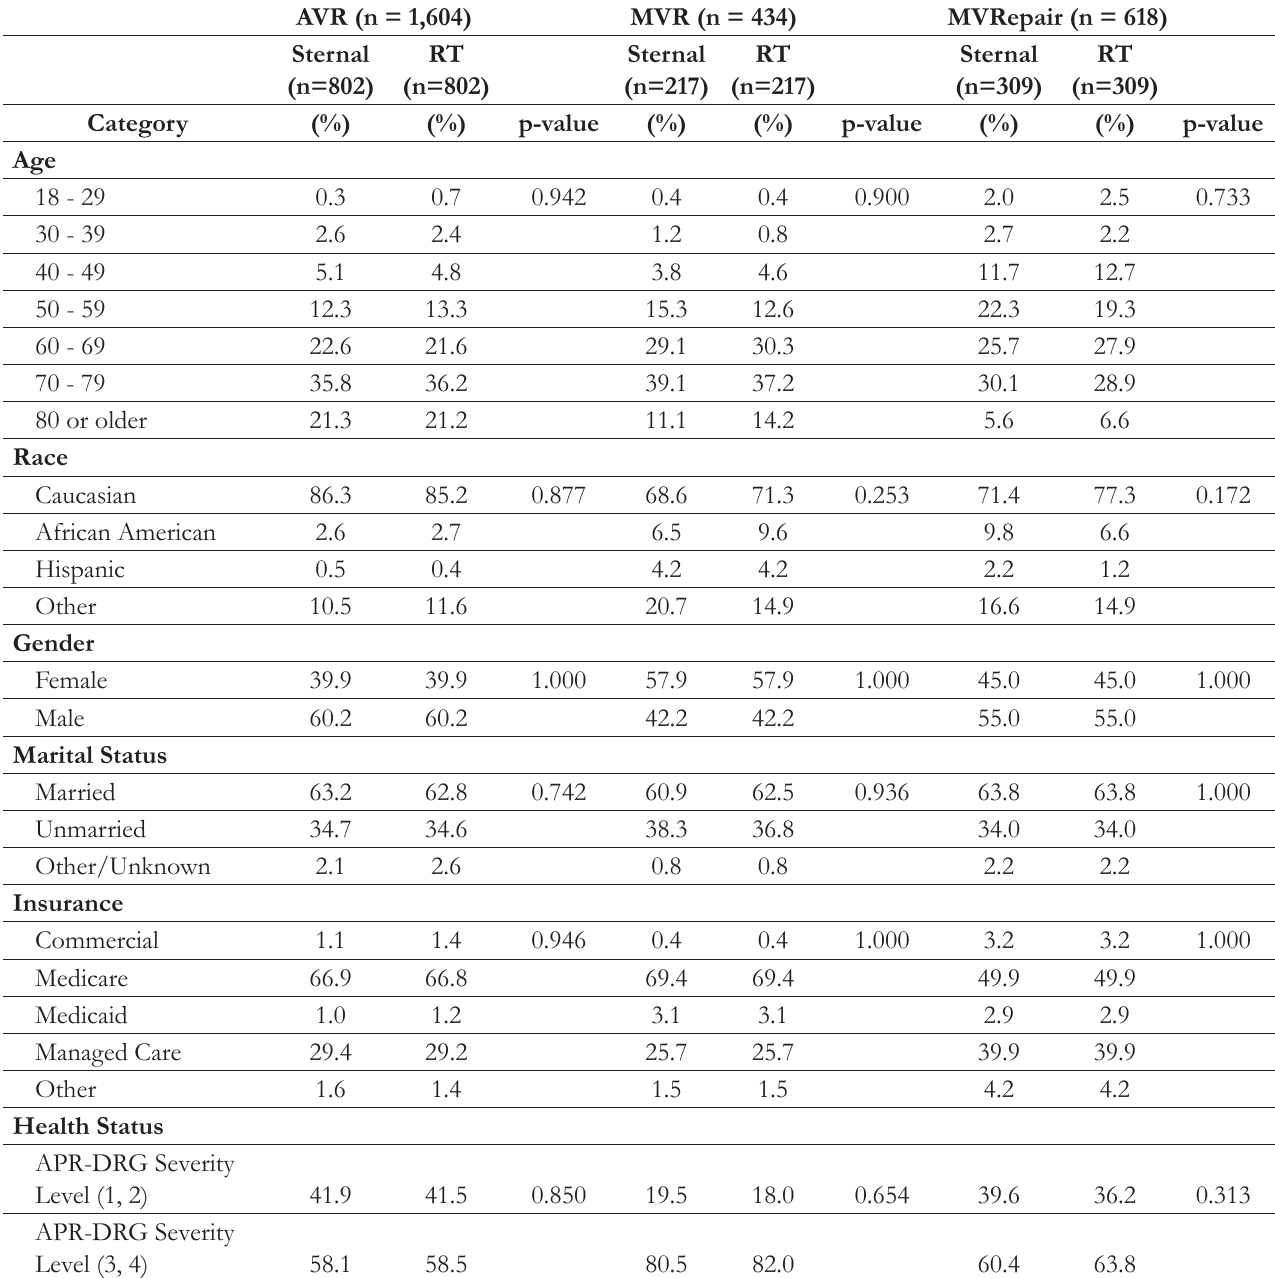
Table 1. Patient Characteristics After